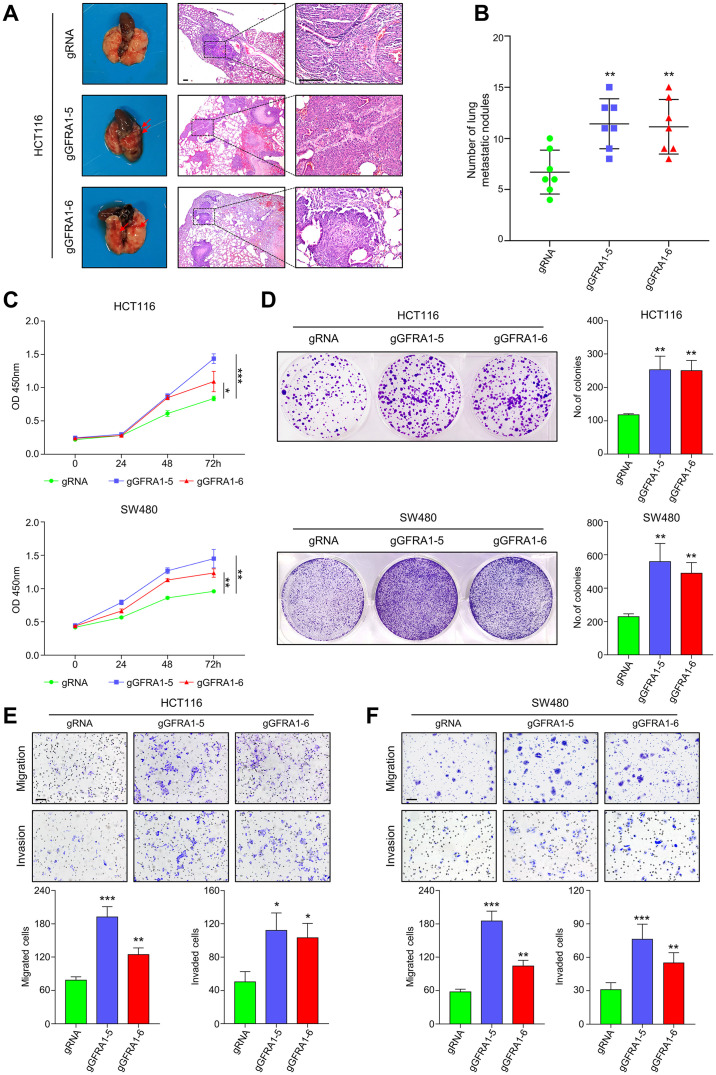
Hypomethylation of GFRA1 promotes metastasis of CRC.A-B Female BALB/c nude mice were injected in tail vein with either HCT116 cells with targeted demethylation of GFRA1 (pPlatTET-gGFRA1-5 and pPlatTET-gGFRA1-6) or respective control cells (pPlatTET-gRNA), n = 7 mice per group. Representative hematoxylin and eosin-stained images presented to show tumor lesions in the lungs (scale bar, 100 μm). The scatter plots show the number of lesions in the lungs as mean± SD (**p < 0.01; Student’s t-test). C CCR8 experiment demonstrates the effect of GFRA1 demethylation on cell proliferation in HCT116 and SW480 cells (*p < 0.05, **p < 0.01, ***p < 0.001; Student’s t-test). D Effects of the loss of GFRA1 methylation on clonogenic spheroid formation in CRC cells was detected by clonogenic spheroid formation assay (**p < 0.01; student t-test). E-F Effects of GFRA1 hypomethylation on cell migration and invasion, as evaluated by Transwell assays in CRC cells (*p < 0.05, **p < 0.01, ***p < 0.001; Student’s t-test), and data are mean ± SD from at least three independent experiments. Scale bars represent 100 μm.